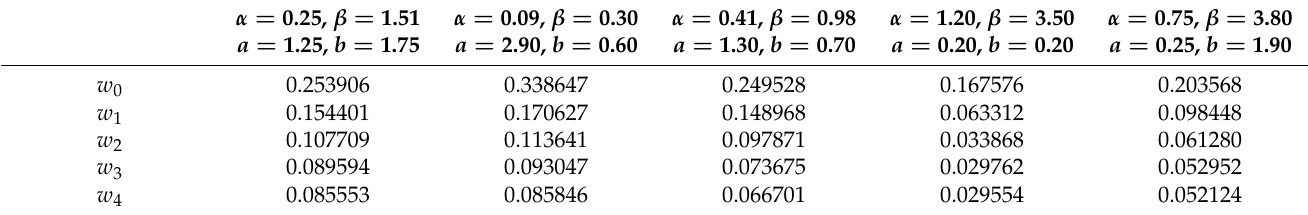
Table 5. The one-sided Hausdorff distance d computed by (19) for reccurent family (18). α = 0.25, β =